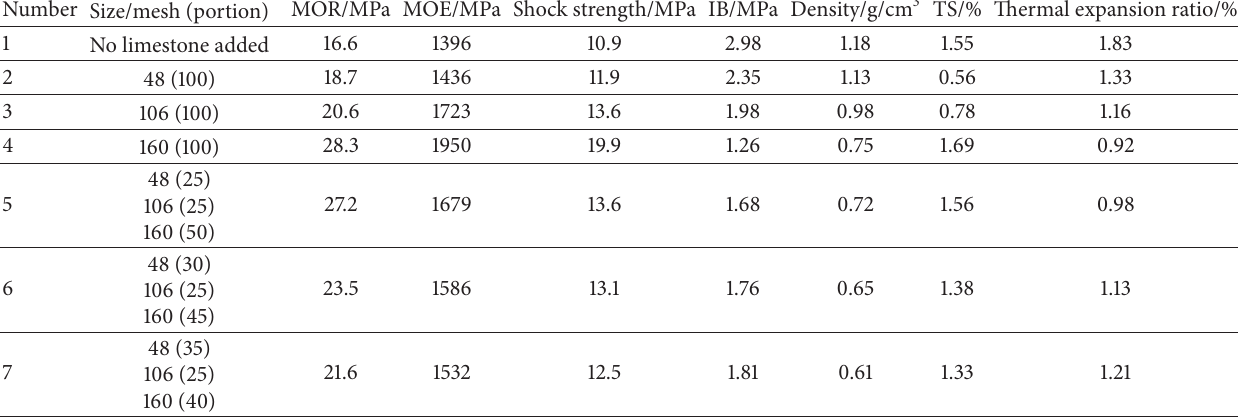
Table 2: Effects of limestone particle size and size distribution on the performance of wood composite